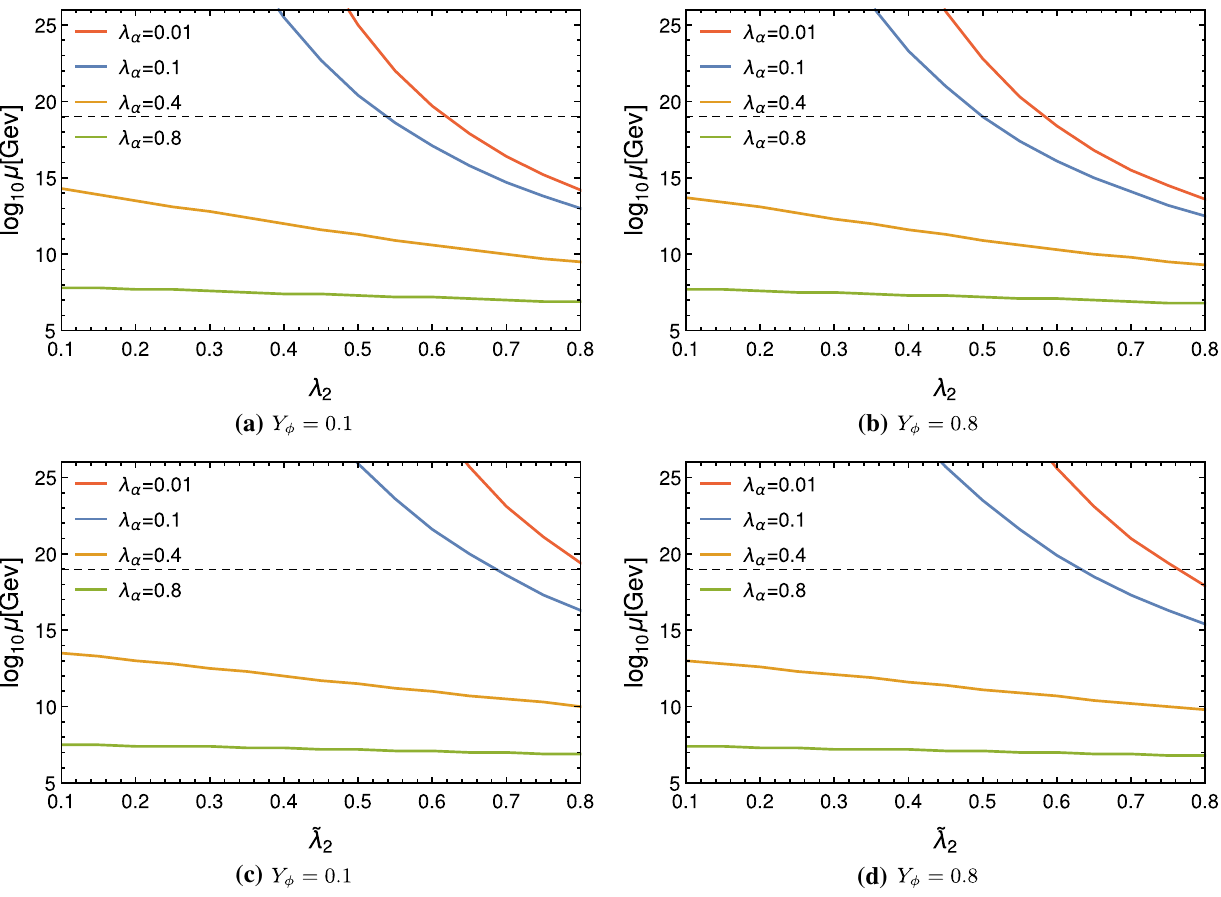
Fig. 7 Variation in quartic couplings λ 2 and (cid:2) λ 2 with the perturbative scale for one generation of (cid:2) R 2 + S 3 . Here, for the λ 2 variation, λ α corre- sponds to { (cid:2) λ 2 ,λ 3 , (cid:2) λ 3 }, and if we consider the behaviour of (cid:2) λ 2 , then λ α includes λ 2 ,λ 3 and (cid:2) λ 3 . All quartic couplings other than that for which the variation is considered are assigned four different values at the EW